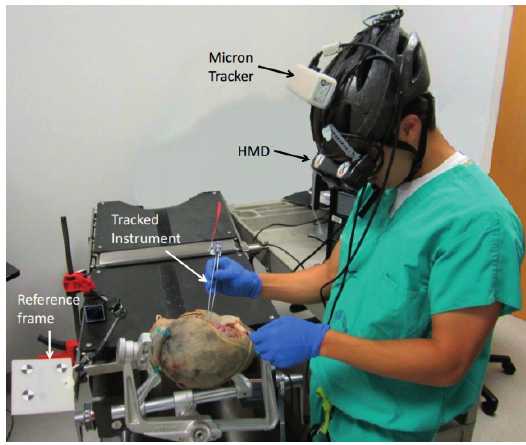
Figure 1. Cadaver experiment with head mounted tracking system and